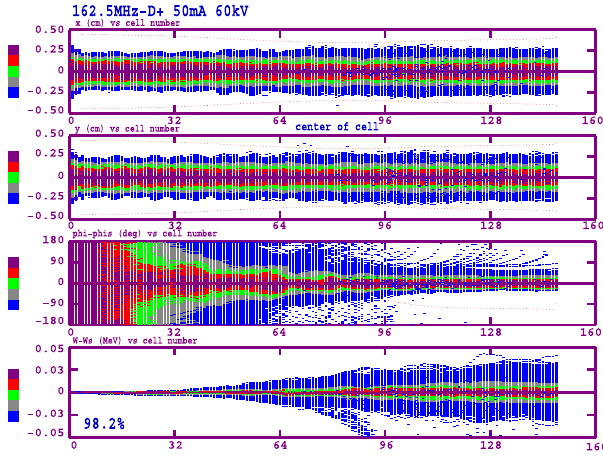
FIG. 5. Beam transmission along the RFQ. Plots from top to bottom are the beam profiles in the x and y planes and phase and energy spectrums, respectively.